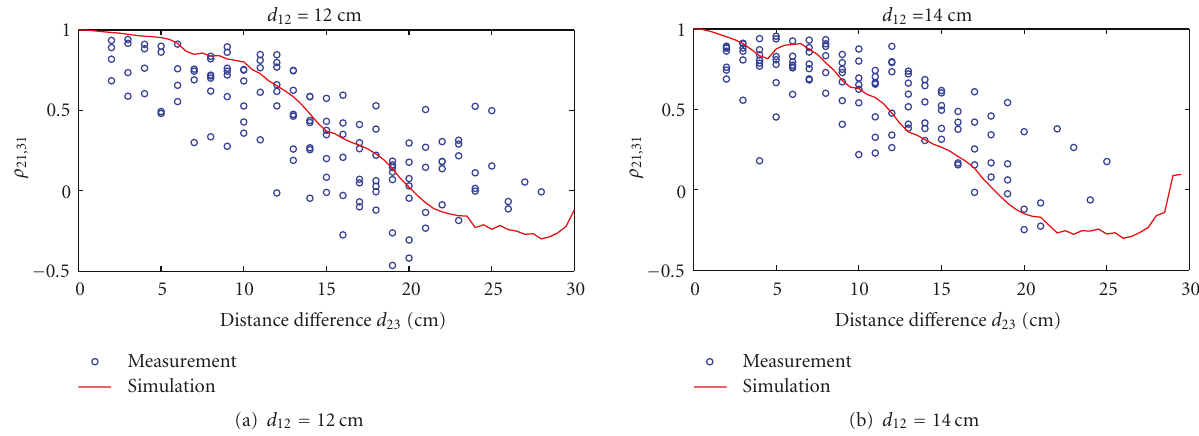
Figure 9: Comparisons of channel fading amplitude (dB) correlation coe ffi cient ρ 21,31 for tangential z -polarization scenarios around the trunk with di ff erent lengths of d 12 .